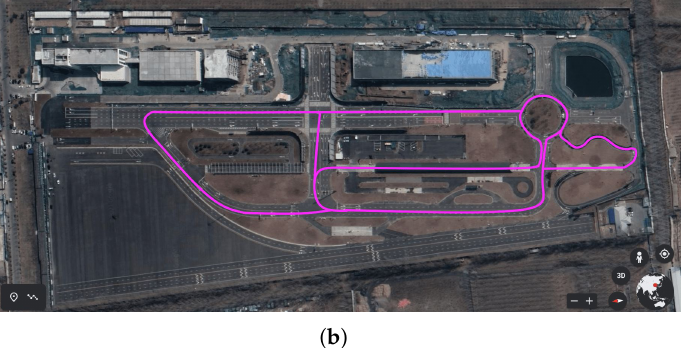
Figure 19. InTEn-LOAM’s map result on autonomous driving field dataset. ( a ) the constructed point cloud map, ( b ) local remote sensing image and estimated